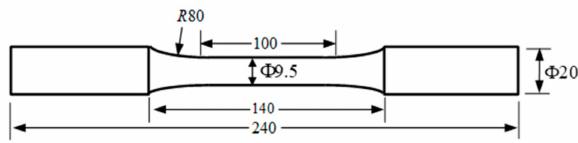
Figure 1. Dimension of smooth cylindrical specimen (mm).